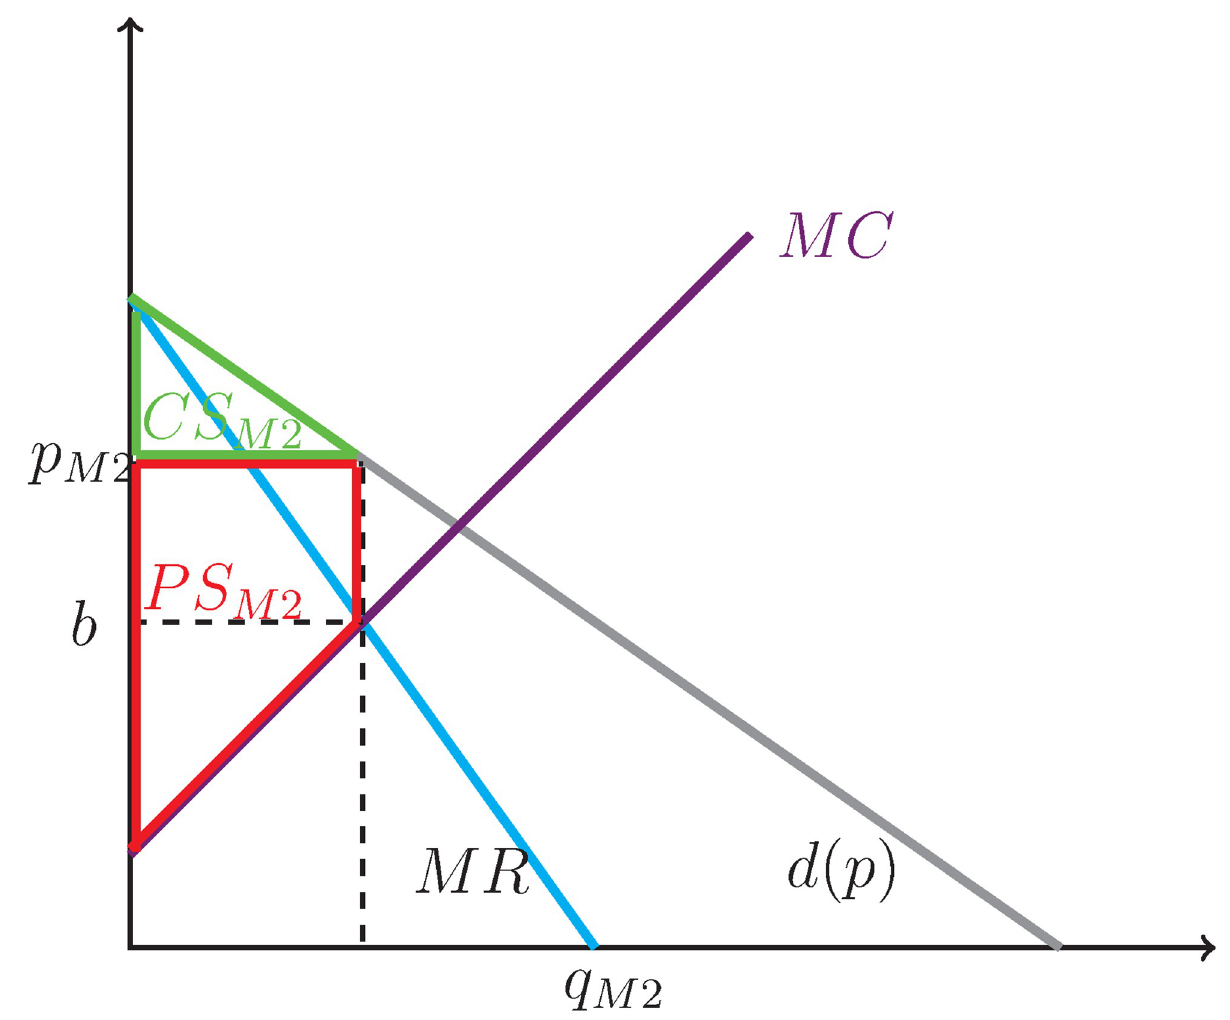
Fig 2. Case 1, market 2: Monopoly with increasing marginal